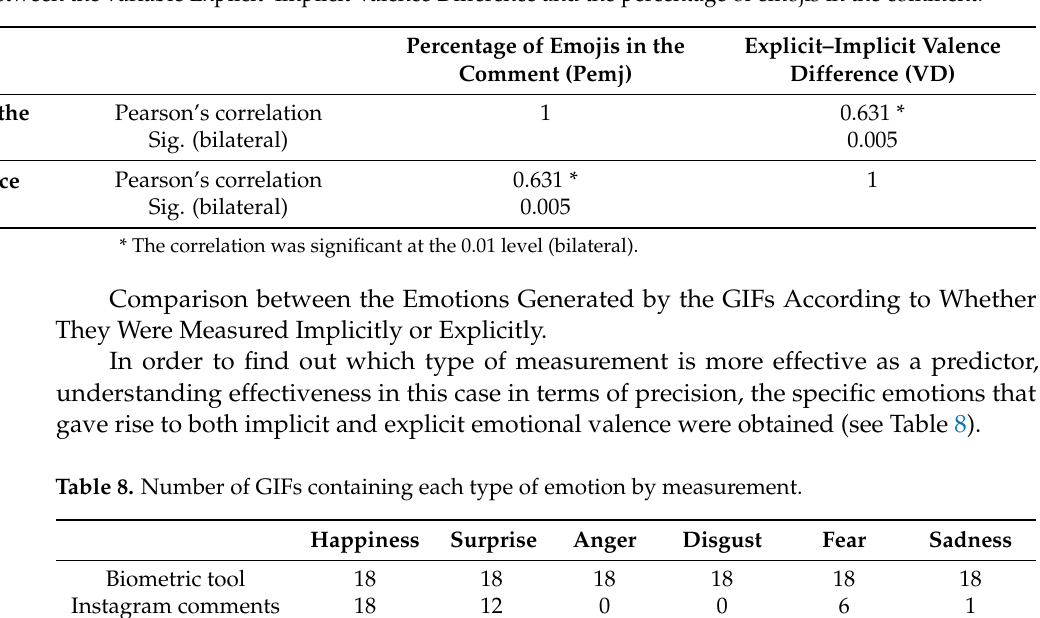
Table 7. Correlation between the variable Explicit–Implicit Valence Difference and the percentage of emojis in the comment.